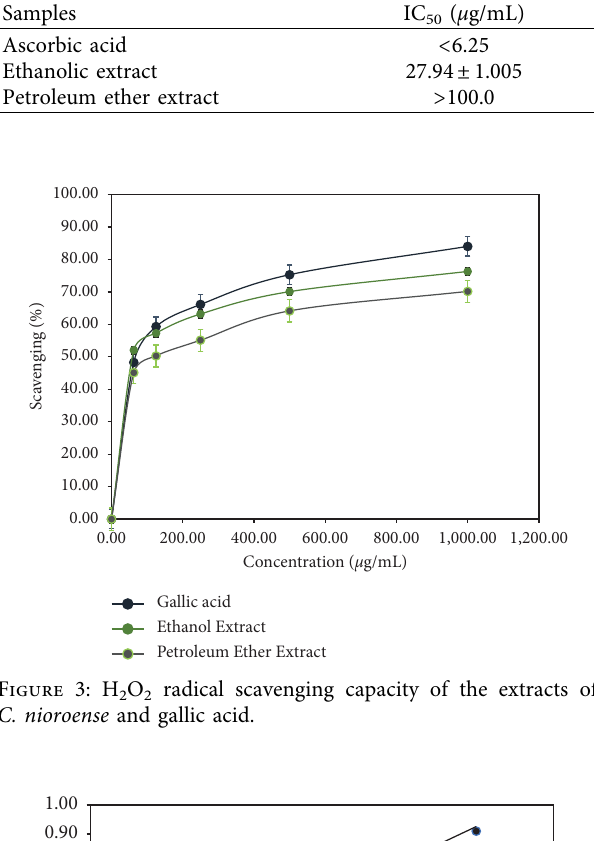
Mo VI O 7 − against the con- 40 4 8